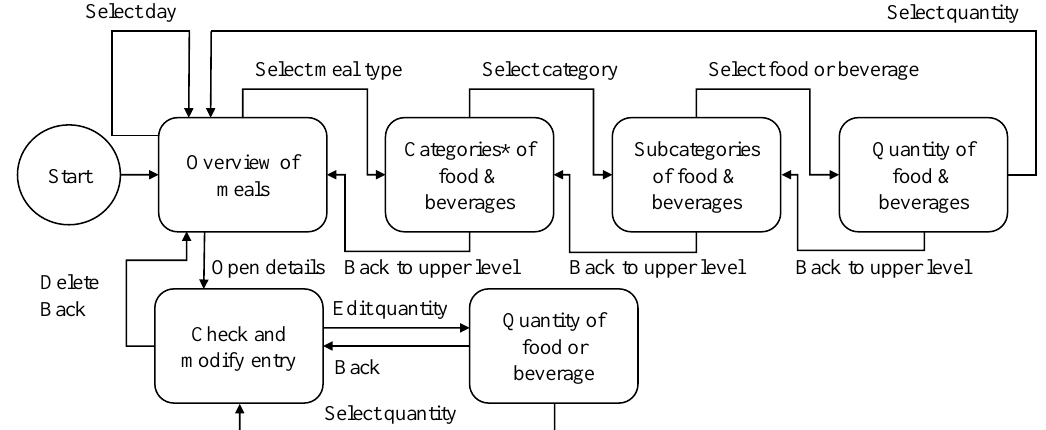
Figure 1. Overview of the architecture of DNDv1, including all possible navigation steps for recording foods and beverages. Notes: (*) For DNDv2, two additional categories were added: the “Most used” and the “Supplements” categories. Furthermore, the selection of the day is limited to today, yesterday,